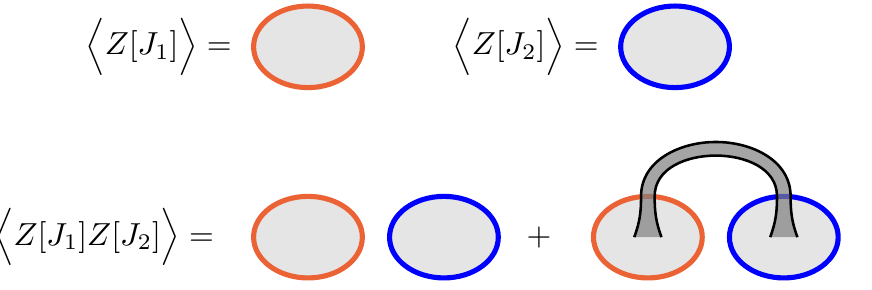
Figure 1 . The gravitational path integral with spacetime wormholes does not factorize. The top line gives a diagramatic representation of the path integrals de(cid:12)ne partition functions Z [ J 1 ] and Z [ J 2 ]. The natural path integral a pair of boundaries yields all terms generated by multiplying additional connected contributions schematically shown as the second term in the bottom